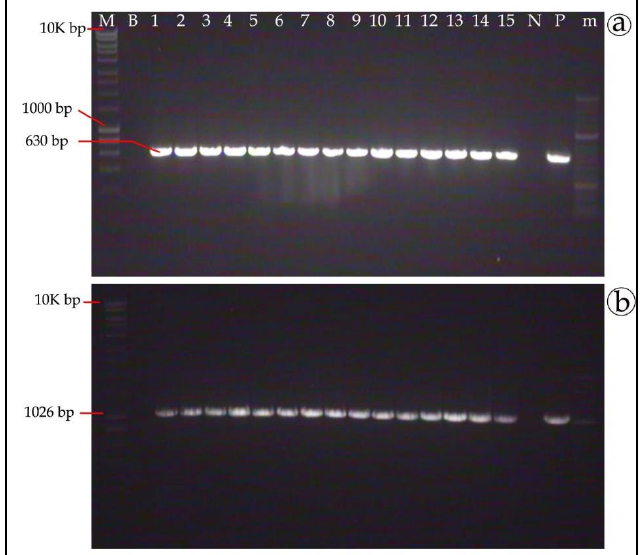
Figure 6. Genetic stability of the integrated plasmid in T. boudieri transformed clones . After 5 rounds of growth on antibiotics-free medium, gDNA was analyzed by PCR amplification for the integrated reporter genes. ( a ) Amplification of the GFP gene (amplicon size 630 bp) in gDNA extracted from geneticin-resistant mycelia. ( b ) Amplification of the RFP gene (amplicon size 1026 bp) in gDNA